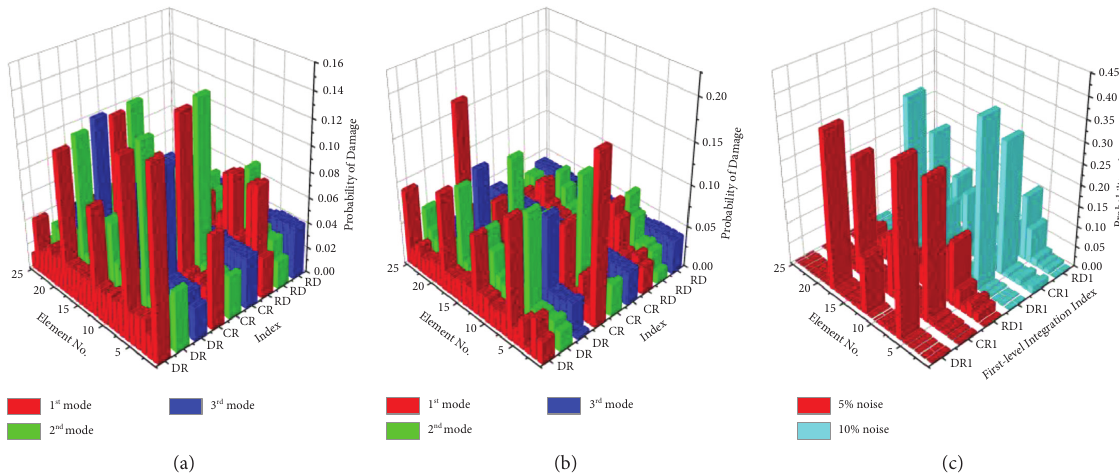
Figure 16: Antinoise analysis results of case 20. (a) 5% noise level of single index. (b) 10% noise level of single index. (c) 5%, 10% noise level of first-level fusion index.